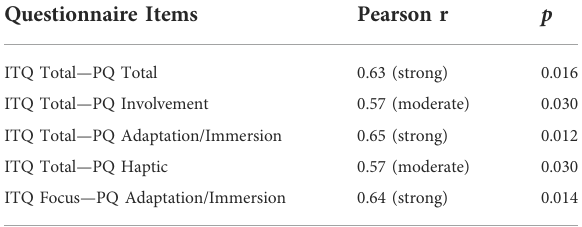
TABLE 2 Correlations among ITQ and PQ